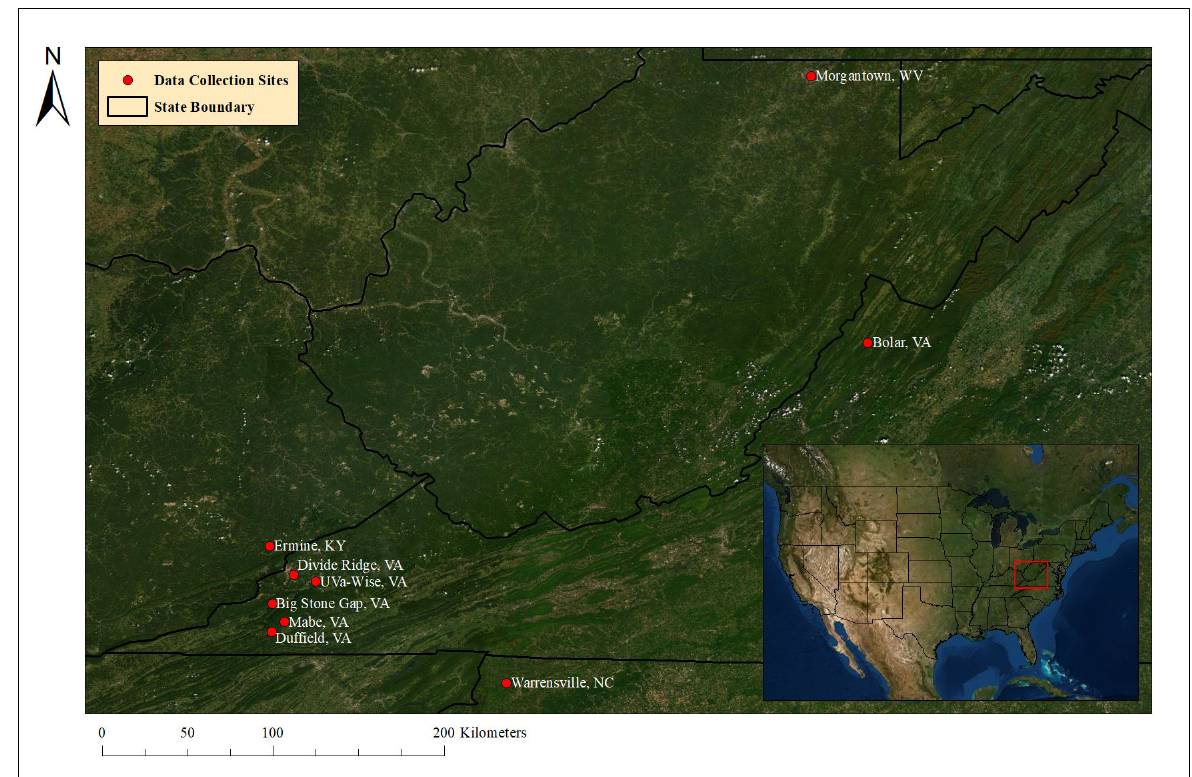
Figure 1. Map of Field